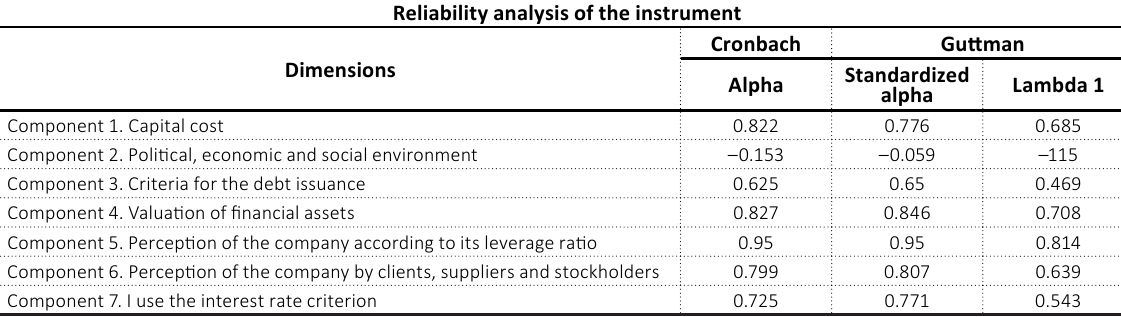
Table 3. Reliability tests of the first instrument (Scale